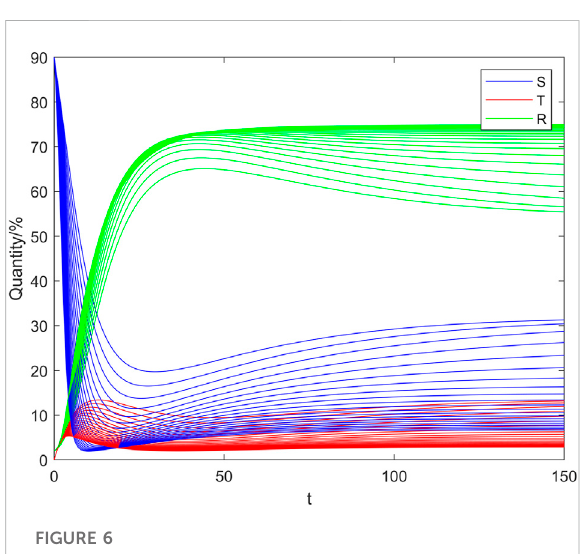
FIGURE 6 Variations in the numbers of S , T , R when R 0 >